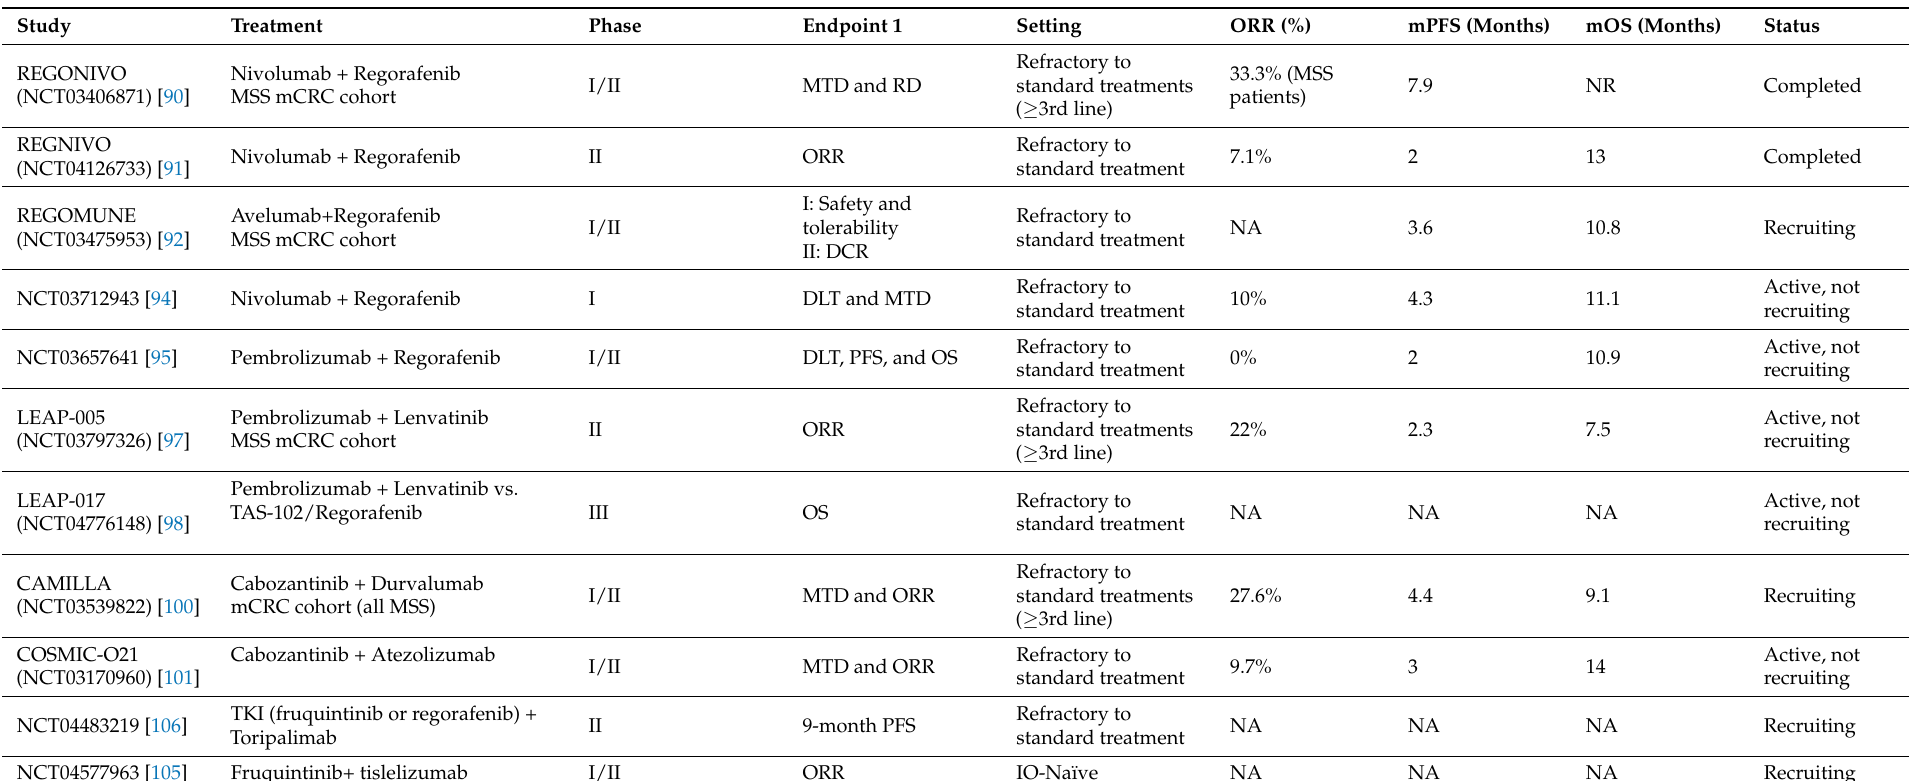
Table 6. Currently ongoing and completed clinical trials of multikinase inhibitors (Anti-VEGFR) and ICIs in MSS